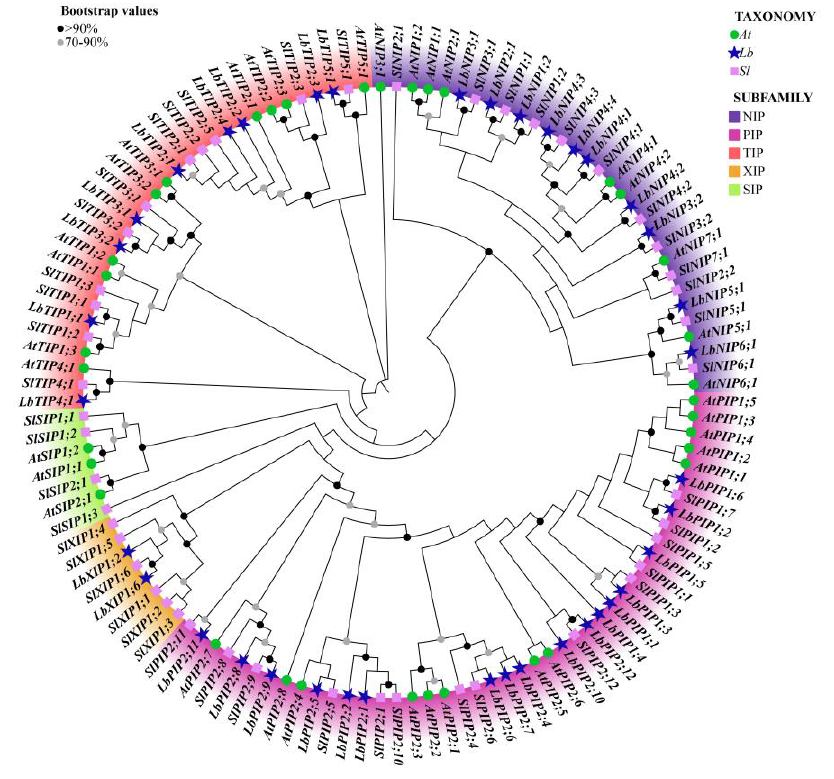
Figure 1. Phylogenetic analysis of the 38 Lycium barbarum AQPs (LbAQPs) with Arabidopsis and tomato homologs. Deduced amino acid sequences were aligned using ClustalX, and a phylogenetic tree was constructed using the bootstrap maximum likelihood tree (1000 replicates) method and MEGAX software. The full-length AQP protein sequences, including 38 members from Lycium barbarum (Lb), 35 members from Arabidopsis thaliana (At), and 47 members from Solanum lycopersicum (Sl), were classified into PIP, TIP, NIP, XIP, and SIP subfamilies, respectively. The branches of different classes have altered colors, and each represents a different subfamily.